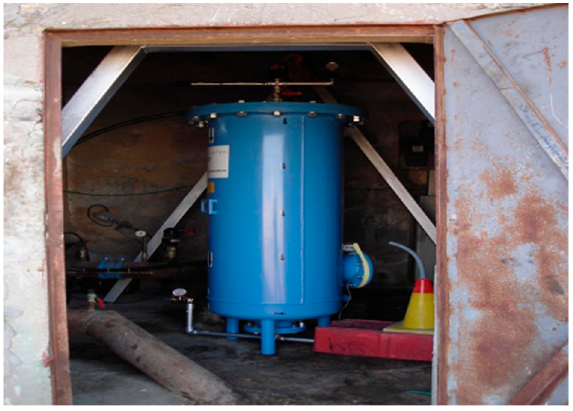
Figure 6. Pilot in a Yashresh well.